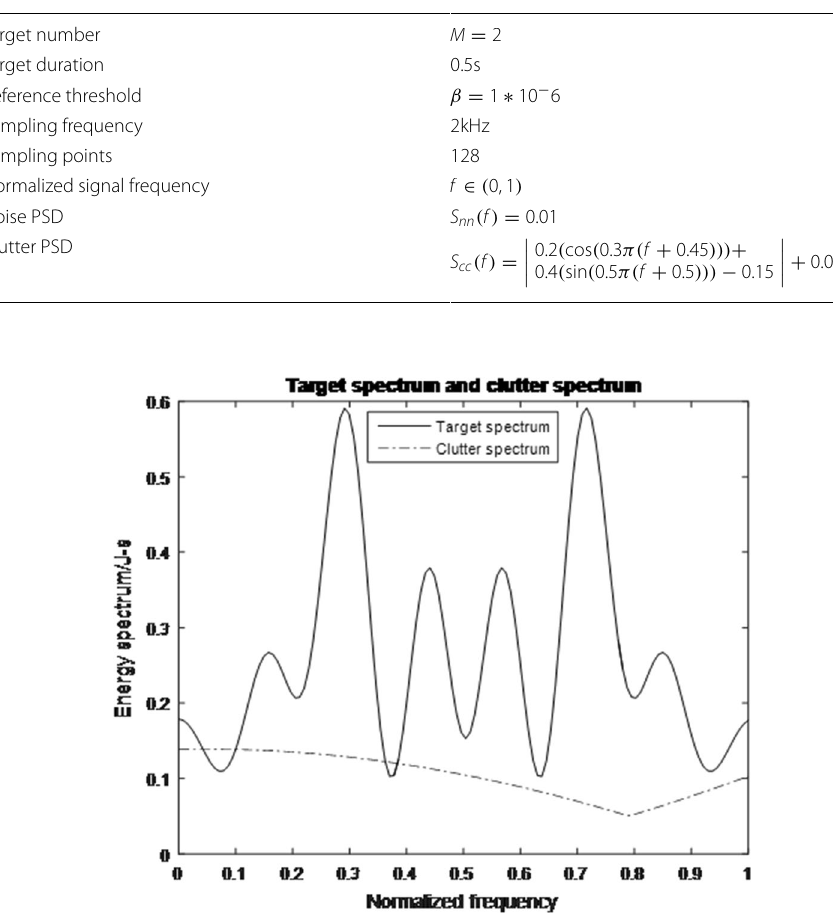
Fig. 6 Total target spectrum and clutter spectrum adopted with maxmin